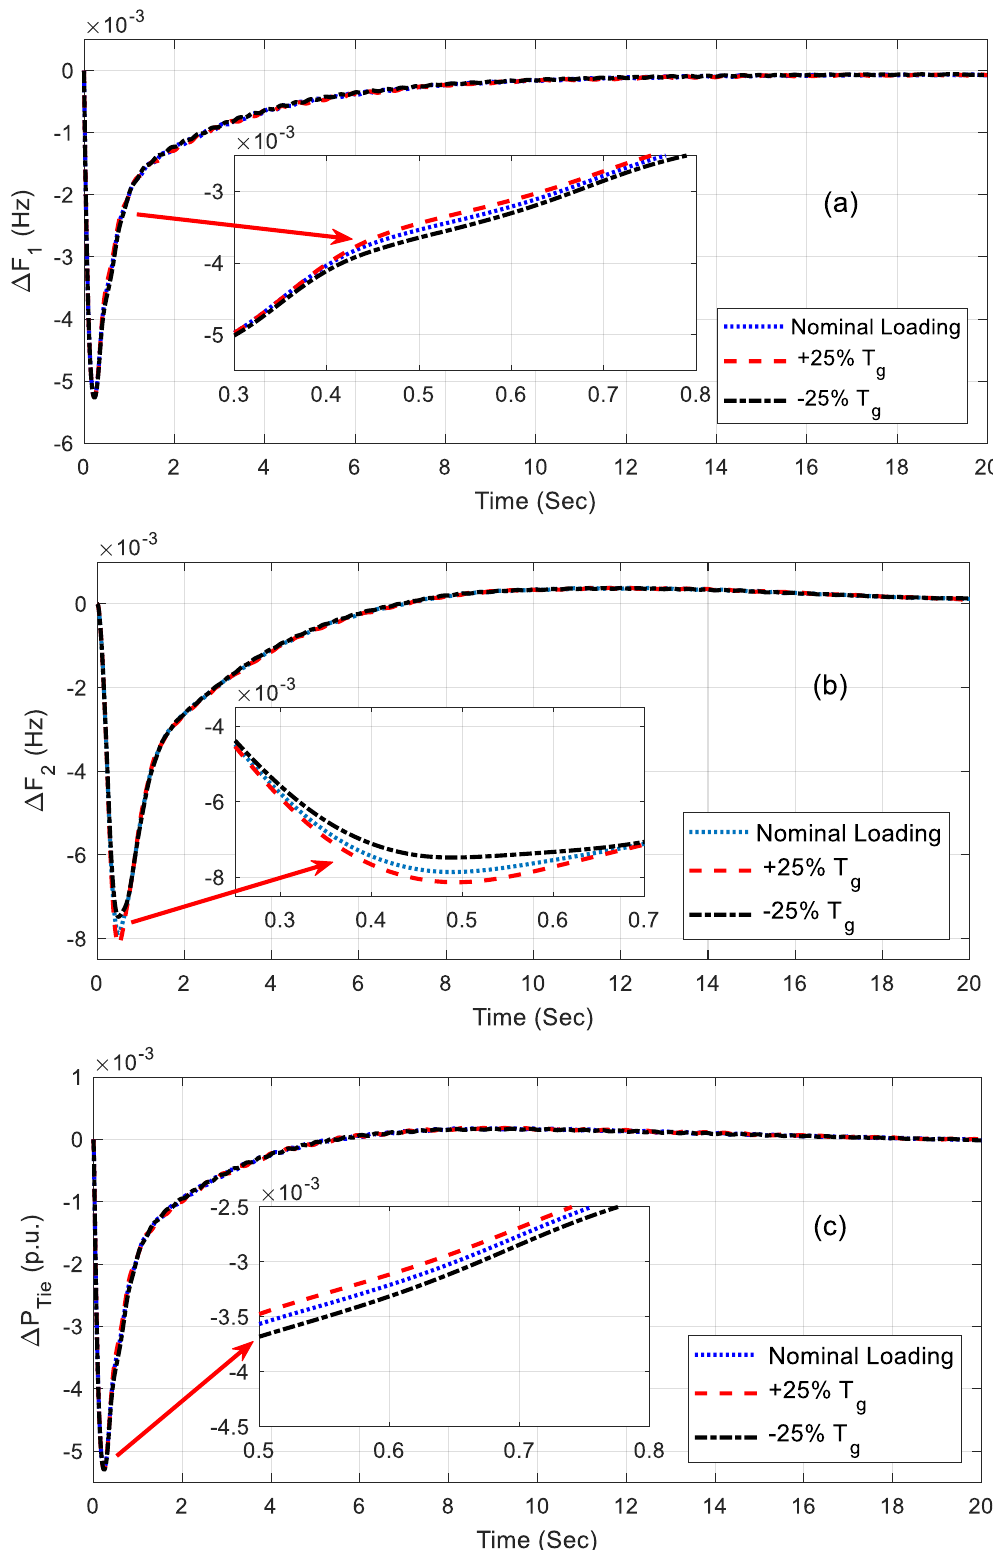
Figure 9. ( a – c ) Responses under T g variation.